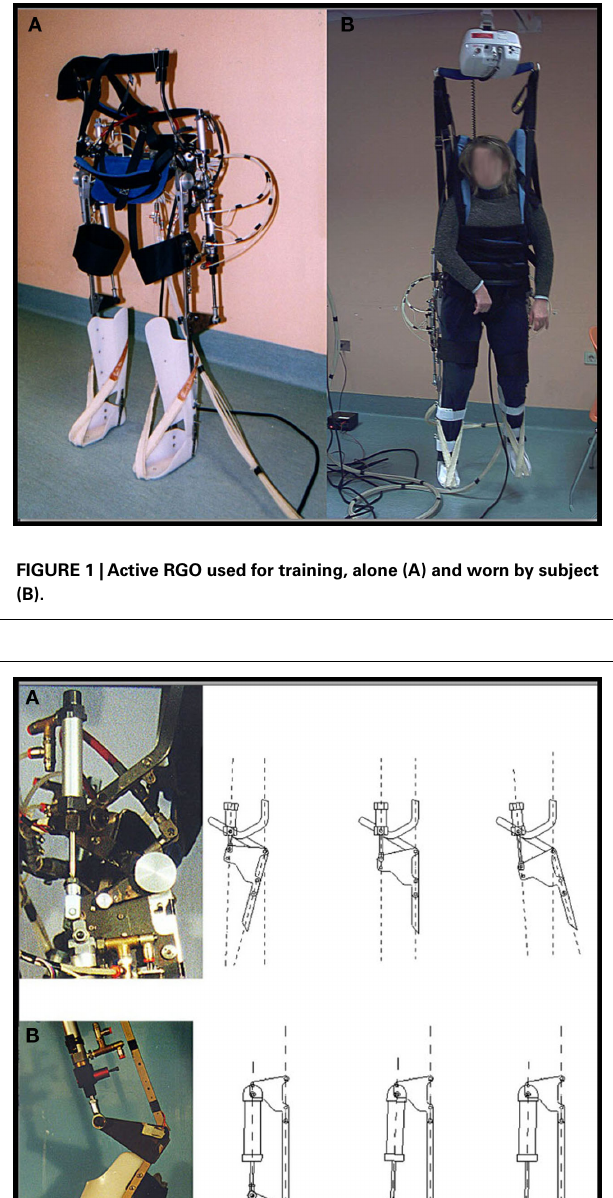
control of the neutral trunk position with respect to the legs.